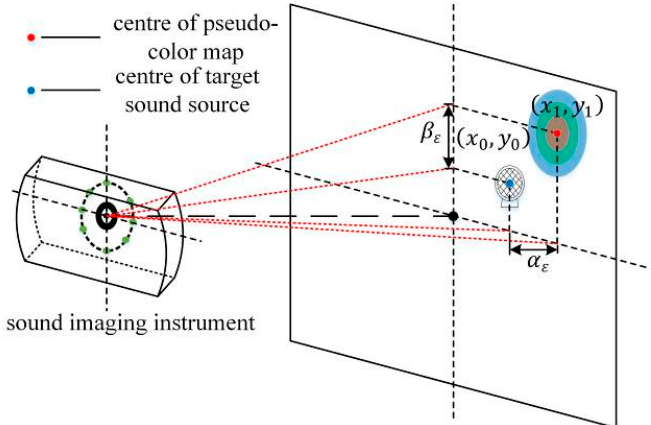
Figure 1. Definition of the positioning error.